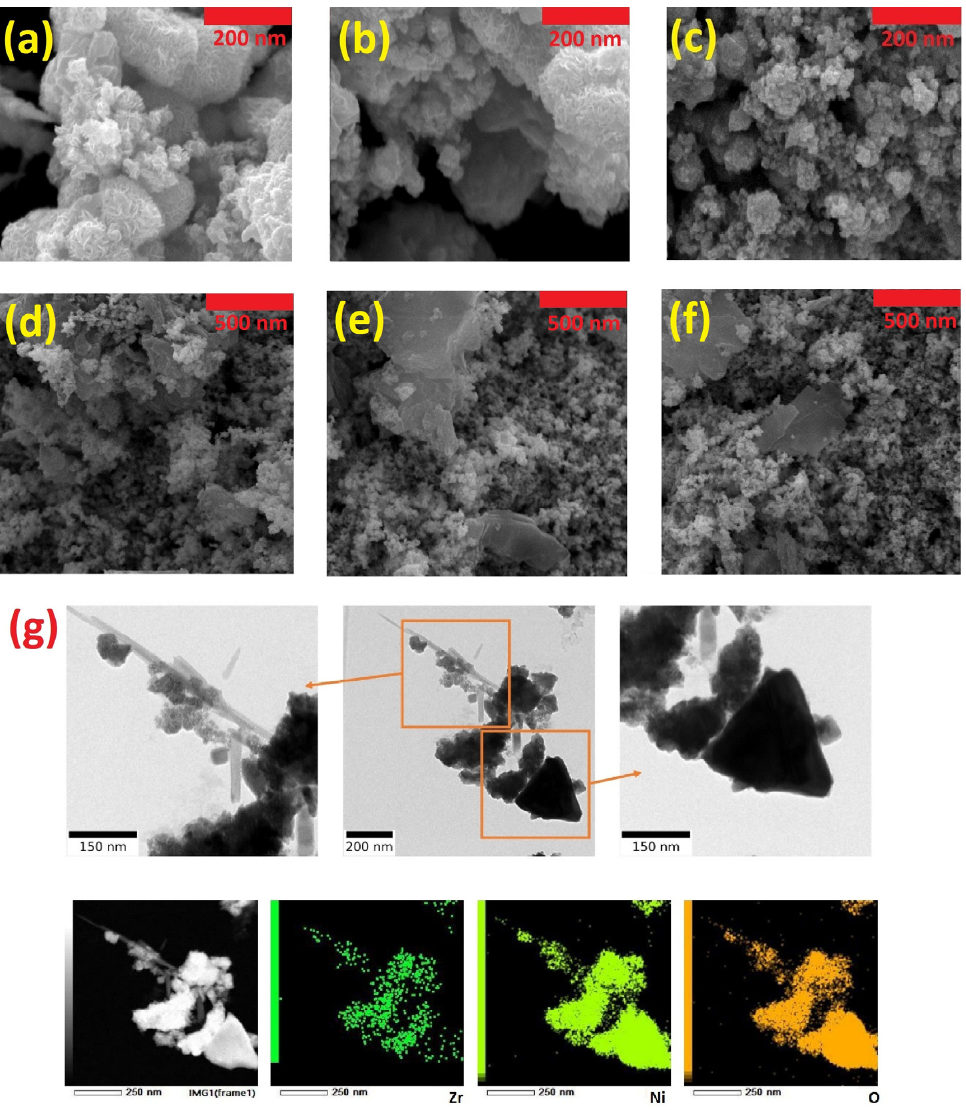
Figure 2. SEM images of ZrO 2 /NiO ( a – c ) and ZrO 2 /NiO/rGO ( d – f ). BF-TEM images and the element mapping patterns of ZrO 2 /NiO ( g ).